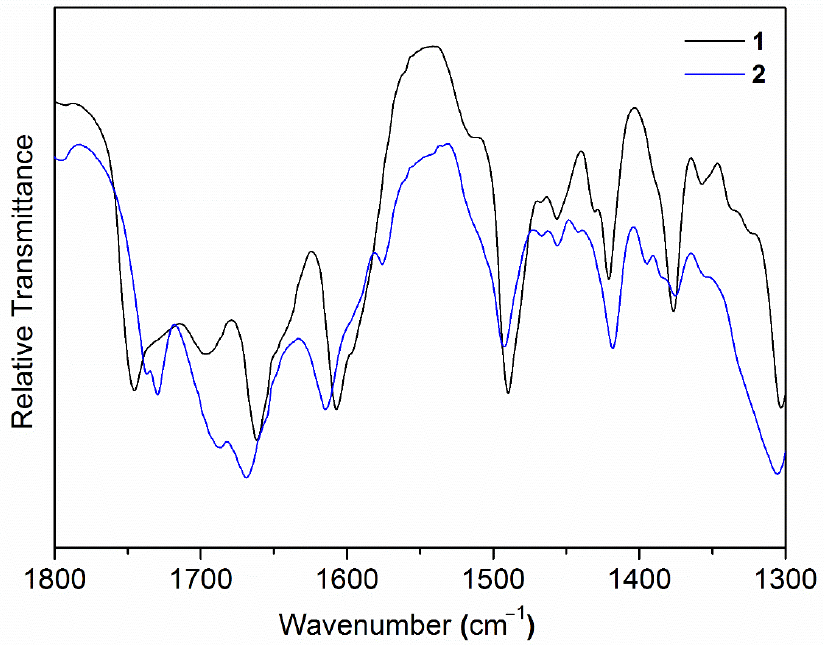
Figure 3. The Fourier-transform infrared (FT-IR) spectra of 1 (black) and 2 (blue) showing the relative intensity of the asymmetric (1607/1615 cm −1 ) and symmetric (1421/1418 cm −1 ) vibrations. The vibration intensity values at 1607 cm −1 and 1615 cm −1 were normalized for comparison purposes.